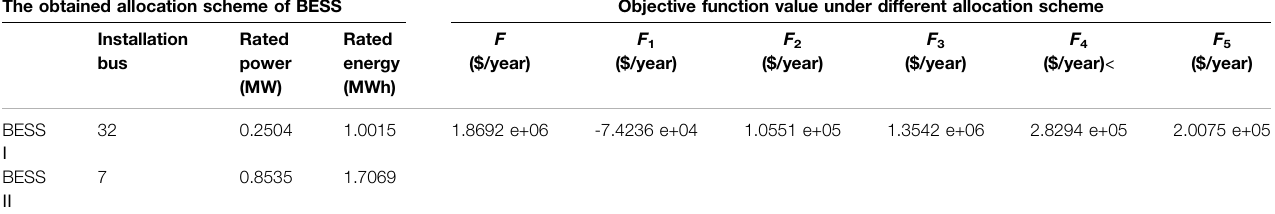
TABLE 3 | Allocation results of IEO algorithms. The obtained allocation scheme of BESS